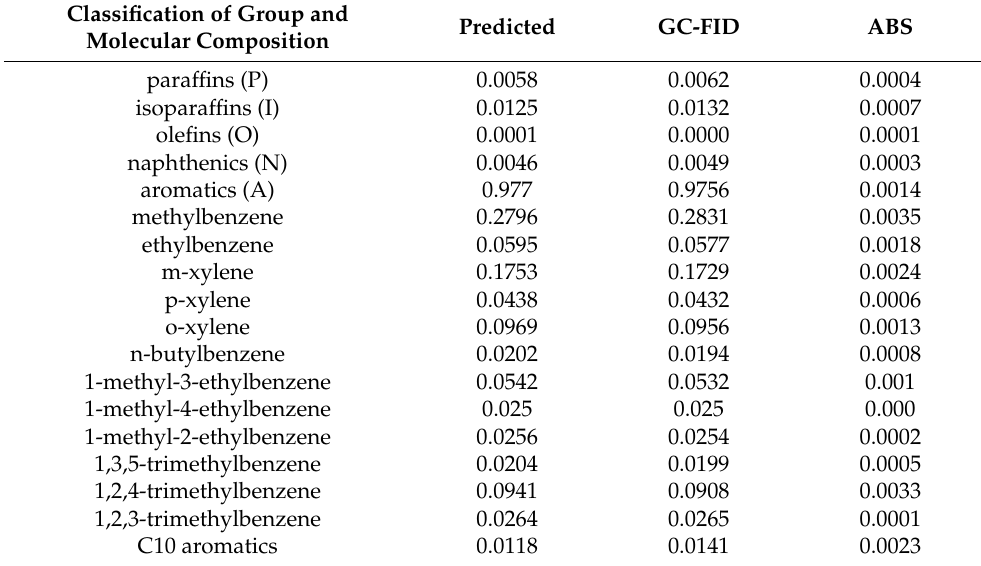
Table 2. The comparison between predicted and measured molecular composition and PIONA composition for sample 2.